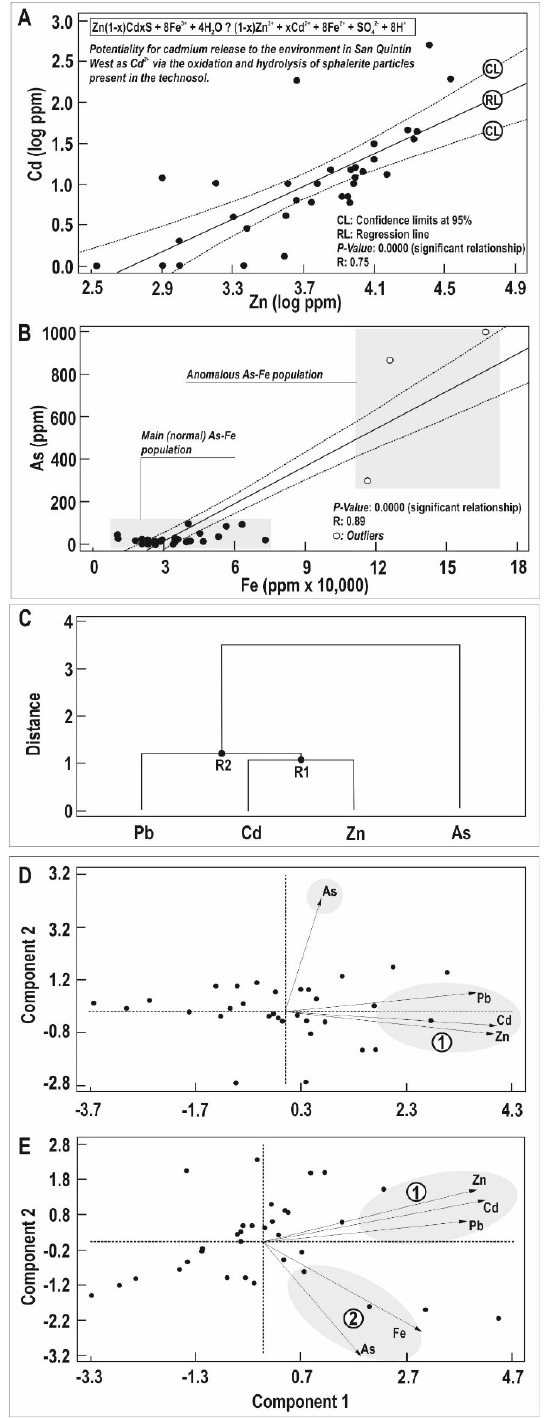
Figure 4. Regression lines and statistical data for the Zn–Cd ( A ) and Fe–As pairs ( B ); note the existence of normal and anomalous populations in ( B ), which may be indicating that the high correlation (0.89) is probably inexistent. ( C ) Clustering analysis and resulting dendrogram (clusters by group average; distances: Squared euclidean) for Pb, Zn, Cd, and As. ( D ) Principal components analysis (PCA) for Pb, Zn, Cd, and As; first, main component: 0.541581 × log Pb + 0.0997684 × log Asc + 0.594177 × log Cd + 0.586251 × log Zn, second component: 0.167213 × log Pb + 0.958876 × log As − 0.121497 × log Cd − 0.194514 × log Zn. (E): PCA for Pb, Zn, Cd, As, and Fe; First, main component: 0.381289 × Fe + 0.495067 × log Pb + 0.235753 × log As + 0.53719 × log Cd + 0.515146 × log Zn; second component: − 0.552223 × Fe + 0.134644 × log Pb − 0.707019 × log As + 0.263836 × log Cd + 0.327771 × log Zn. All statistics calculations run with STATGRAPHIC Centurion XVII (Statgraphics Technologies, The Plains, VA,